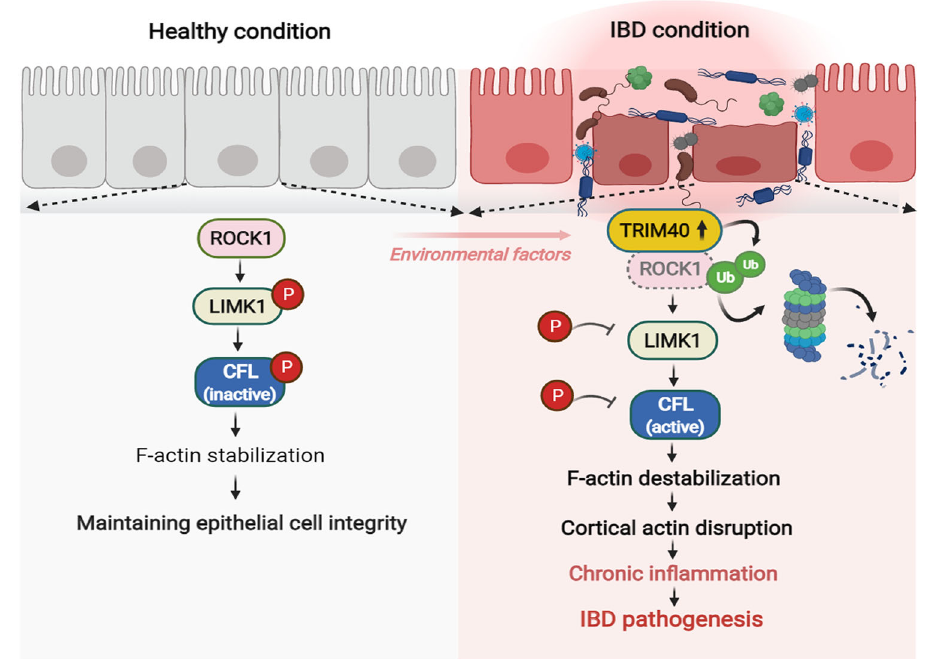
Fig. 6 | Proposed model of upregulated TRIM40-driven IBD initiation and progression. The upregulated expression of typically epigenetically silenced TRIM40 acts as a pathogenic driver of IBD. The proposed mechanism involves the direct targeting of ROCK1 degradation and cortical actin disruption, which